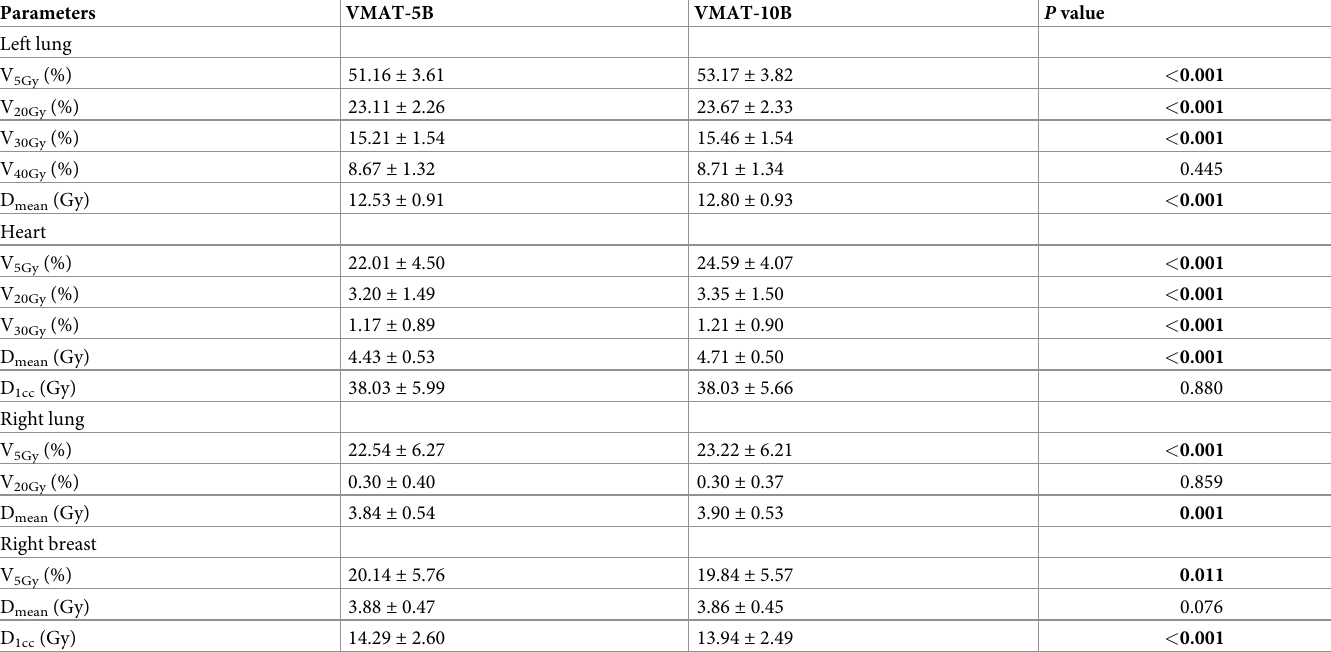
Table 2. Dosimetric comparison between VMAT-5B and VMAT-10B for the OARs. Parameters